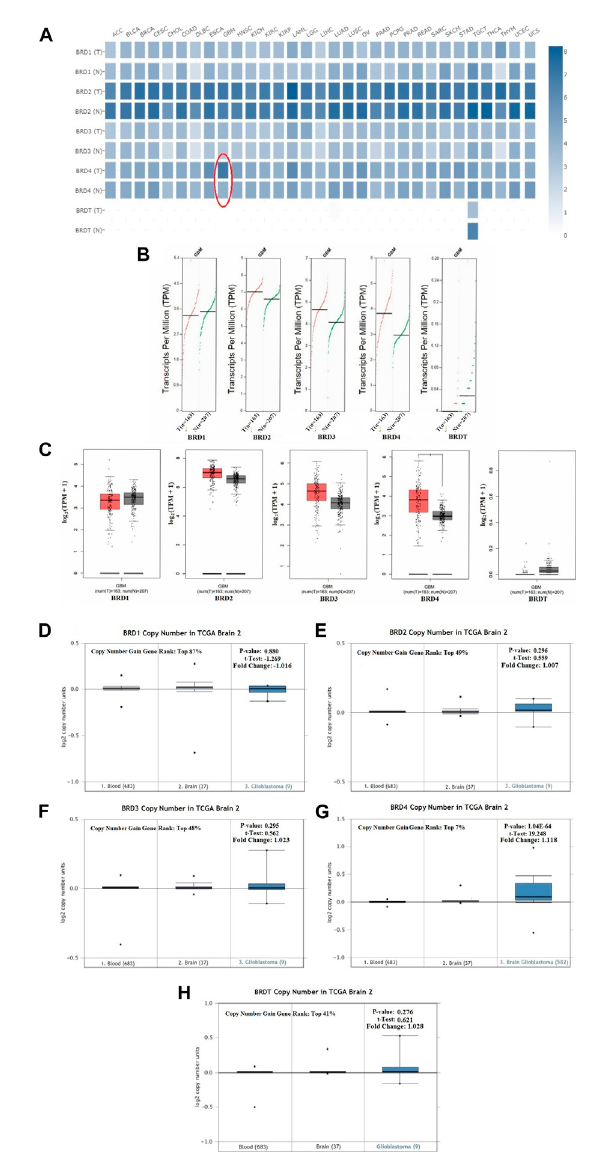
FIGURE 2 The transcription levels of BET genes in GBM samples. (A) Multiple gene comparison in different cancer types were generated in GEPIA database. T:Tumor tissues; N: Normal tissues. (B) The transcription level of BET genes in GBM patients. The scatter diagram of expression of BET genes in GBM. (C) The box plot of BET genes expression in GEPIA database (* p < 0.05). (D – H) The copy number of BRD1, BRD2, BRD3, BRD4, BRDT were shown in TCGA Brain 2 cohort, respectively. The p -values, t -Test, fold change, and copy number gain gene rank were based on Oncomine